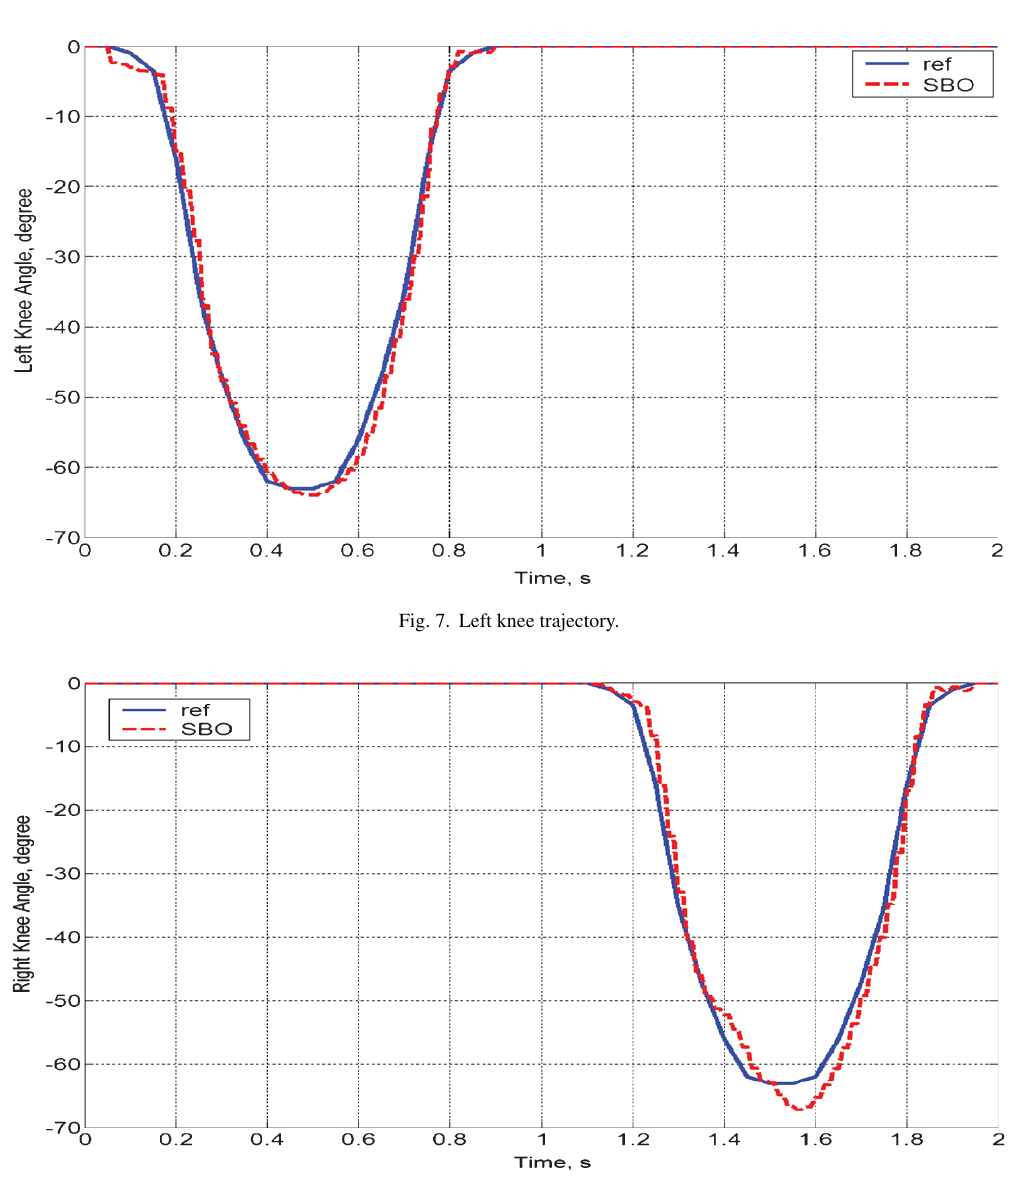
Fig. 8. Right knee